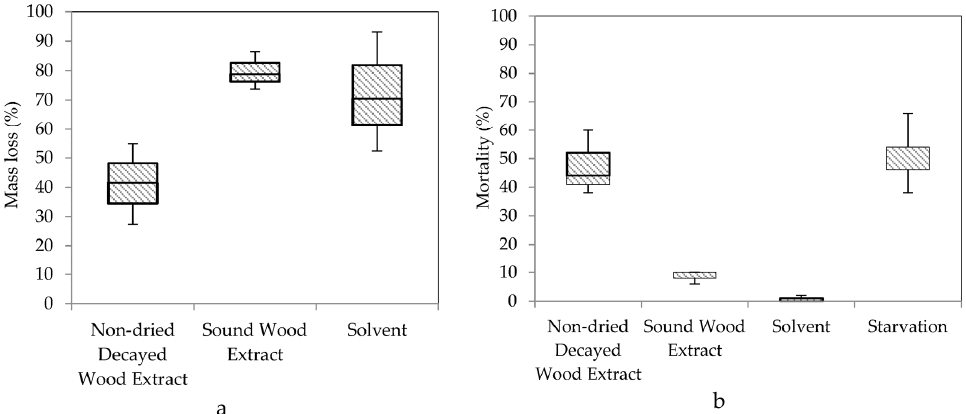
Figure 7. Box plot of mass loss percentage ( a ) of paper disks immersed in the n- hexane extracts of non-dried laboratory-decayed and sound wood and the mortality of termites (b) after 10 days exposure in the no-choice feeding